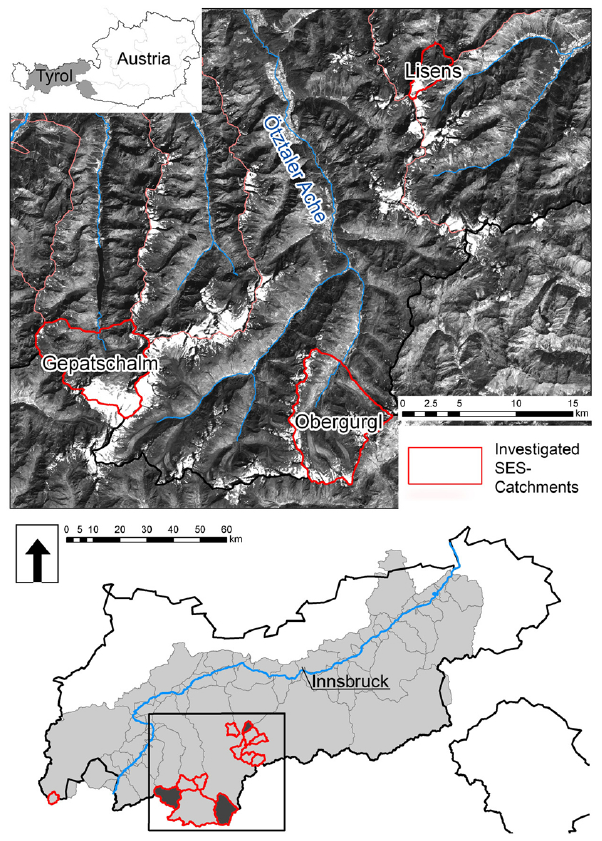
Fig. 1. Glacierized catchments within the model area of the flood forecasting system of the river Inn (gray) with emphasis on the three catchments analysed in this study.